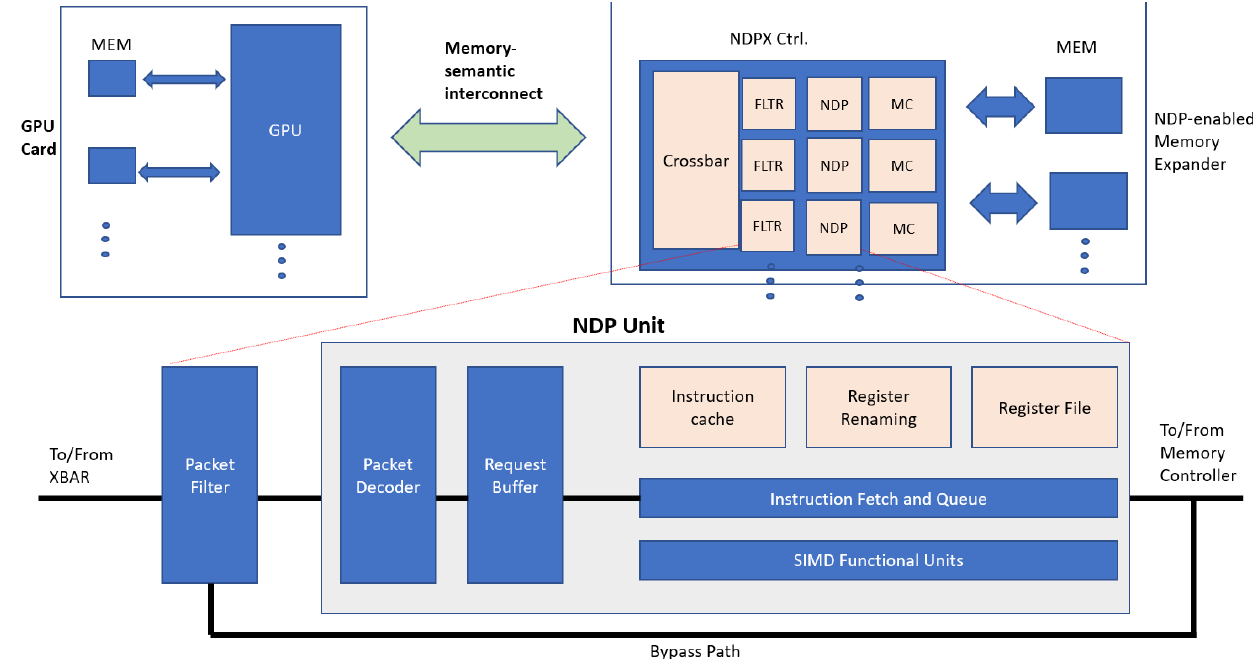
Figure 34. NDPX architecture block diagram [19].